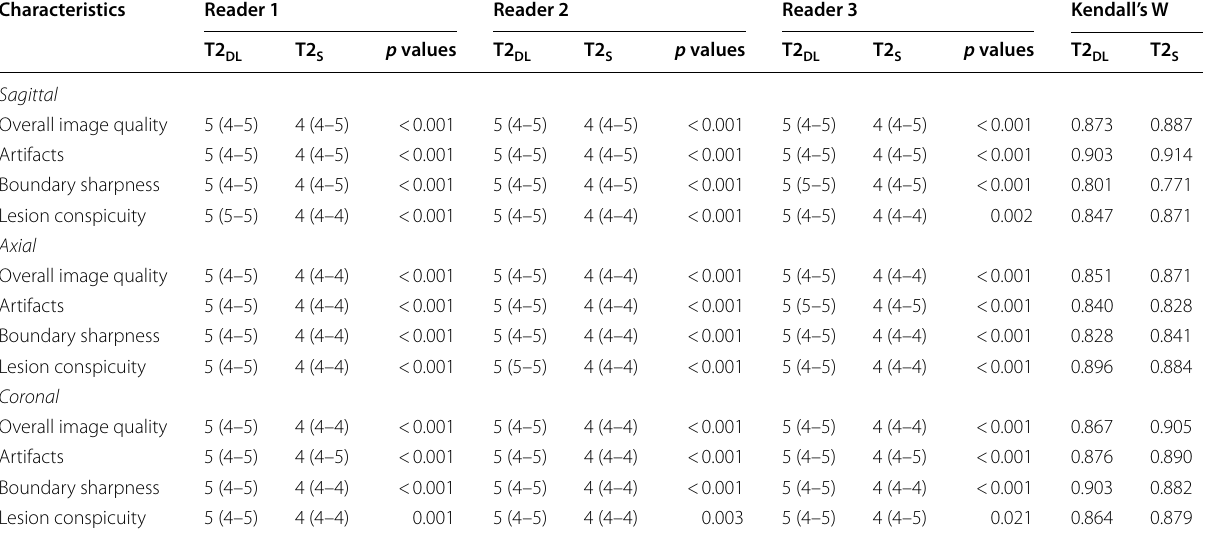
T2 DL deep learning-accelerated T2-weighted turbo spin echo sequence; T2 S standard T2-weighted turbo spin echo